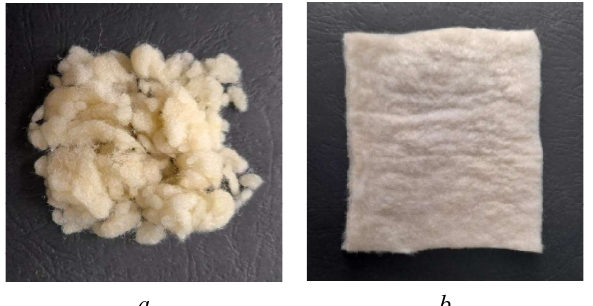
a b Fig. 1. General appearance of the studied samples: a – “cotton wool”; b – “fabric”